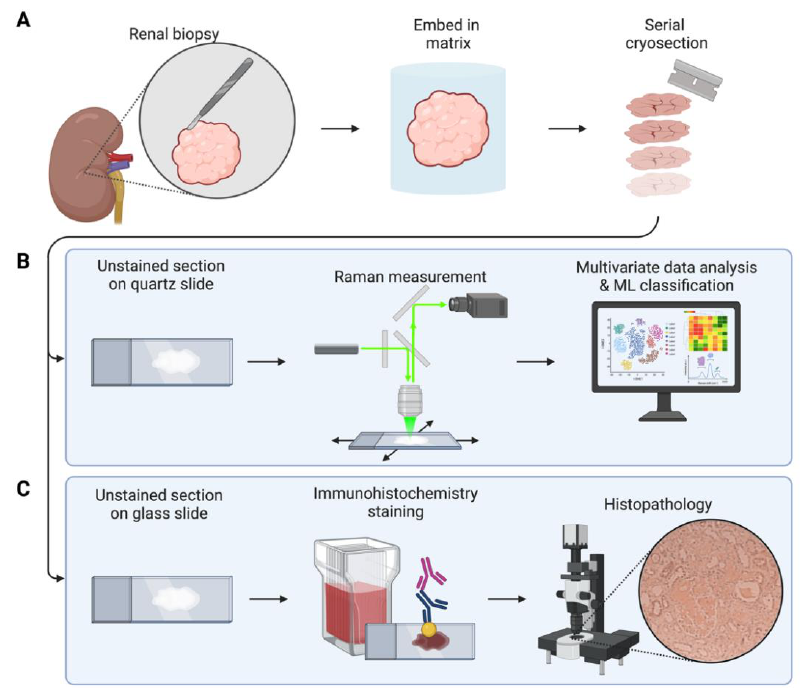
Figure 1. The overall workflow for amyloid identification and subtyping. ( A ) Tissue preparation steps. Biopsied tissues were frozen and sectioned for evaluation. ( B ) Raman spectroscopic data acquisition and analysis. Fresh frozen tissue sections were prepared on quartz slides to minimize spectral interference, and employed for Raman measurements, which were subjected to machine learning analysis. ( C ) Histopathologic validation. Consecutive tissue sections used in ( B ) were utilized for the gold standard, immunohistochemistry evaluation. (Created with BioRender.com (accessed on 23 February 2023)).